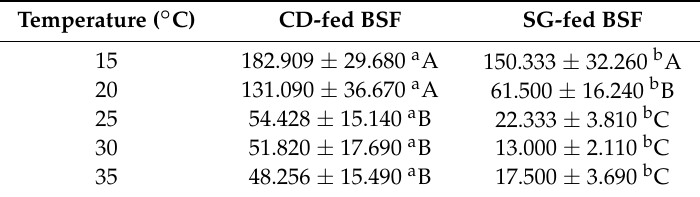
Table 3. Mean ( ± SD) pupal developmental time (in days) of black soldier fly reared on two different organic substrates at five different temperature regimes.